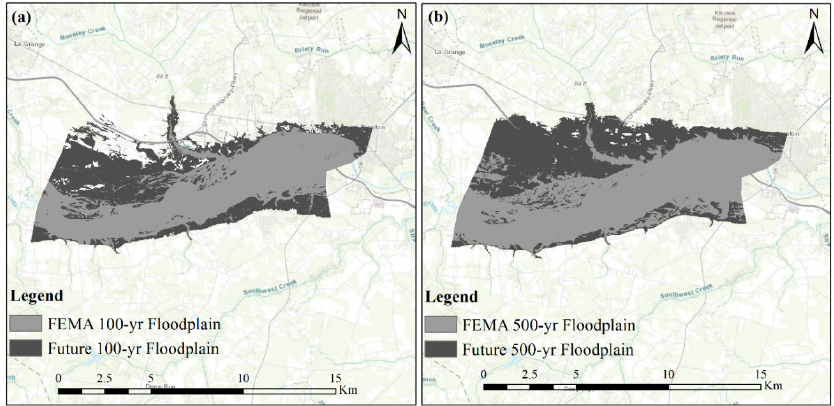
Figure 6. Comparison of flood extent map of Neuse River using the ArcMap (Version 10.7.1)